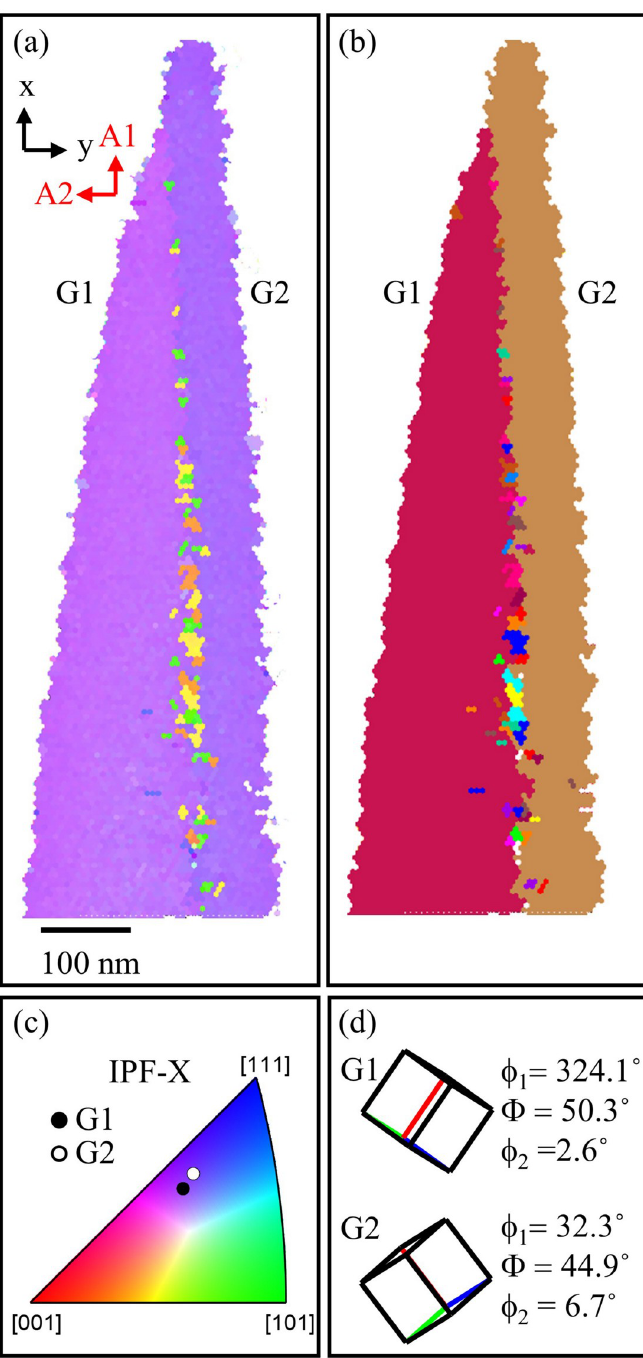
Fig 1. (a) TKD IPF map of the Al bi-crystal atom probe specimen. (b) Unique grain color quick map. (c) IPF-X with crystallographic direction along x -axis plotted. (d) Orientation unit cell and Bunge-Euler notation of grains with TKD detector